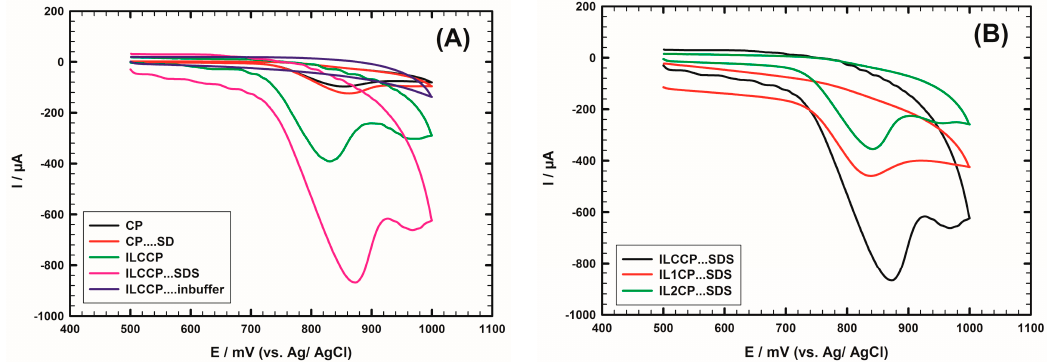
Figure 2. ( A ) CVs of 1 mmol·L − 1 TZ/0.1 mol·L − 1 PBS/pH 7.40 at CPE (black line), CPE…SDS (red line) ILCCPE (green line) and ILCCPE…SDS (violet line). (Blue line) Represents the CV of ILCCPE…SDS in the absence of TZ, scan rate 50 mV·s − 1 . ( B ) CVs of 1 mmol·L − 1 TZ/0.1 mol·L − 1 PBS/pH 7.40 at ILCCPE…SDS (black line), IL1CPE…SDS (red line) and IL2CPE…SDS (green line). Scan rate 50 mV·s − 1 . Table 1. Summary of CV results obtained at CPE, CPE…SDS, ILCCPE, ILCCPE…SDS, IL1CPE…SDS